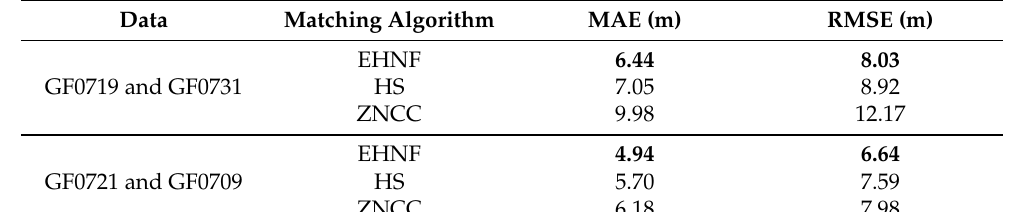
Table 4. Assessment of the elevation accuracy of flat DSMs.